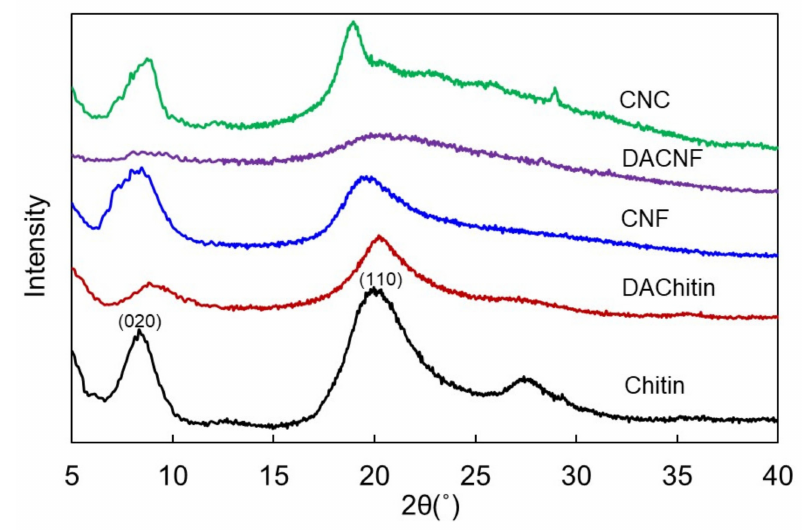
Figure 4. X-ray di ff raction patterns of chitin, deacetylated chitin (DACTN), chitin nanofibers (CNF), deacetylated chitin nanofibers (DACNF), and chitin nanocrystals